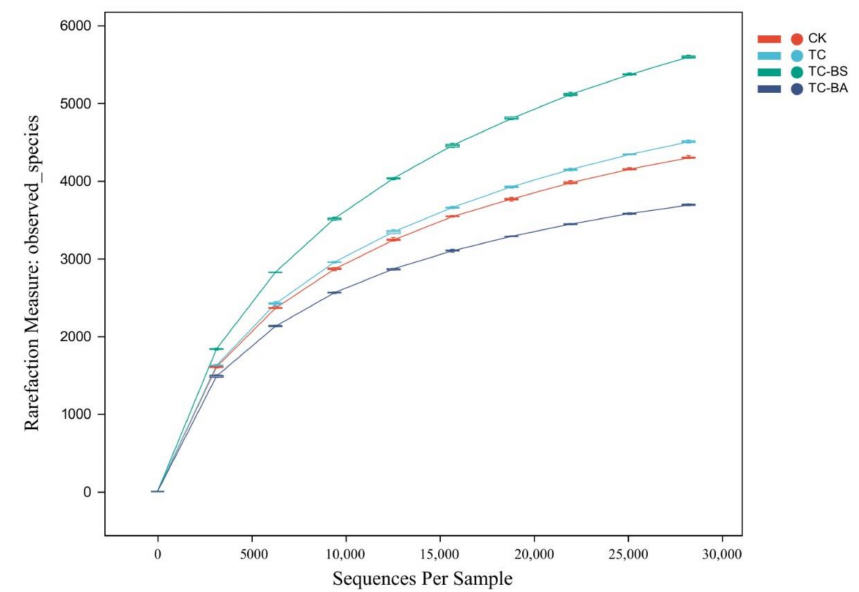
Figure 2. Sparse graph of each sample. CK: no tomato plant residue compost or PGPR; TC: tomato plant residue compost; TC-BS: tomato plant residue compost + B. subtilis ; TC-BA: tomato plant residue compost + B. amyloliquefaciens